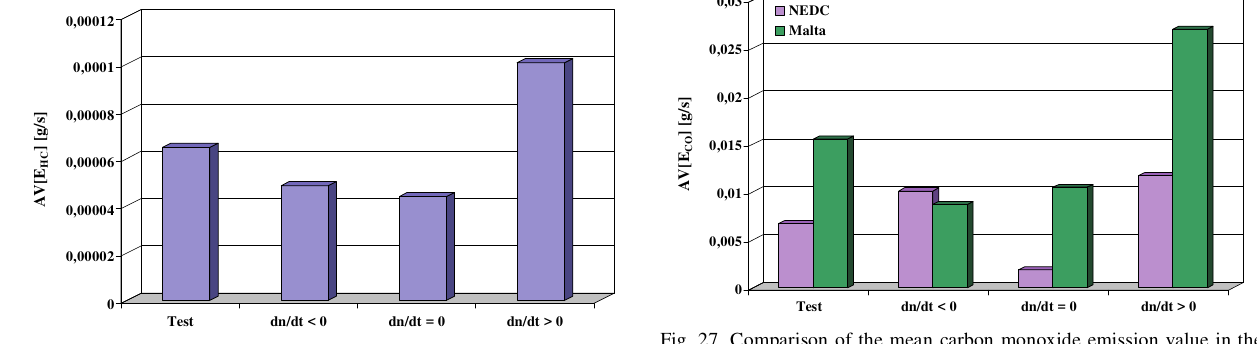
Fig. 23. Mean value of the hydrocarbons exhaust emission in the Malta test and in the states corresponding to the negative, zero and positive values of the engine speed derivative with respect to time